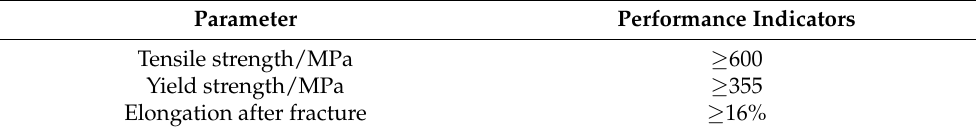
Figure 3. Axial profile of half-grouted sleeve. Table 1. Material properties of